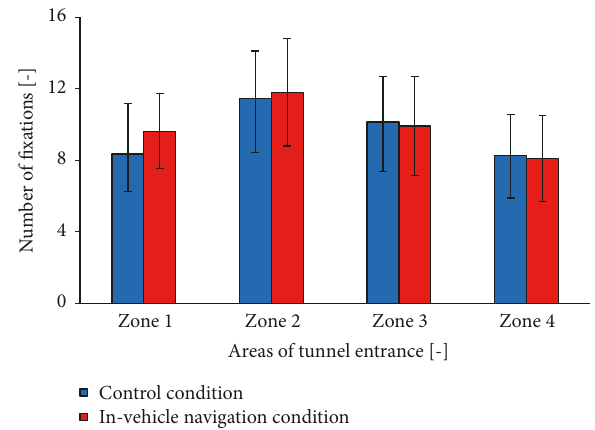
Figure 4: Comparison of the number of fixations between the control and in-vehicle navigation